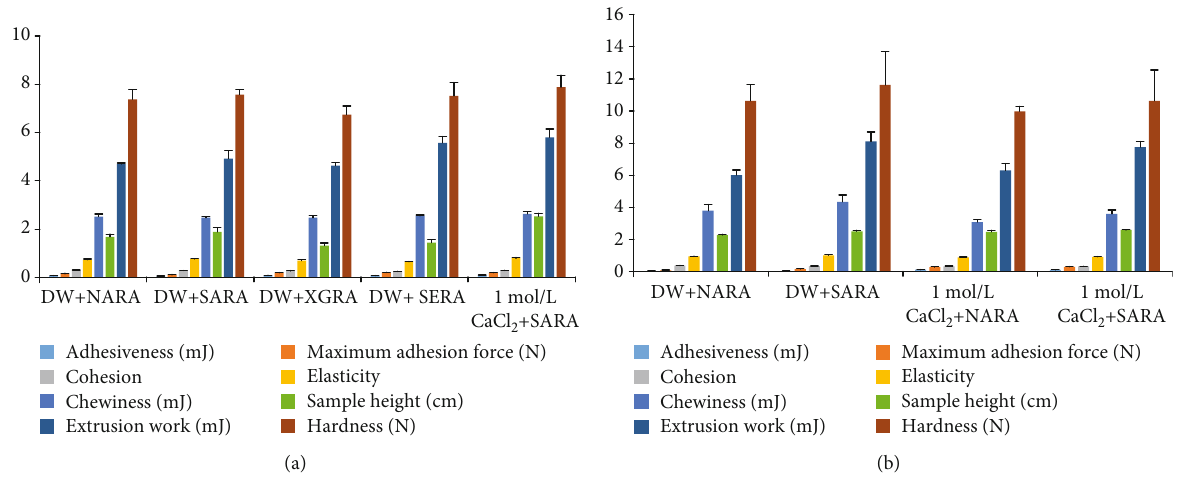
Figure 1: Textural properties of rice analogues: (a) soaking experiment; (b) boiling experiment. DW: distilled water; NARA: rice analogues with nonadditive; SARA: rice analogues containing sodium alginate; XGRA: rice analogues containing xanthan gum; SERA: rice analogues containing sucrose